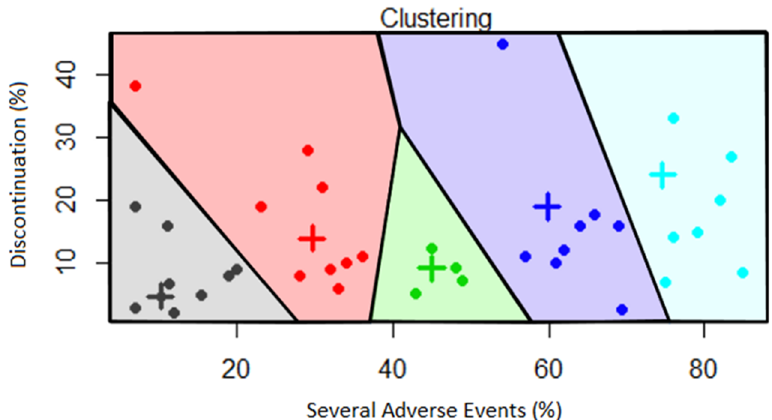
Fig 3. Voronoi tesselation based on Toxicity Index (TI) considering Euclidean